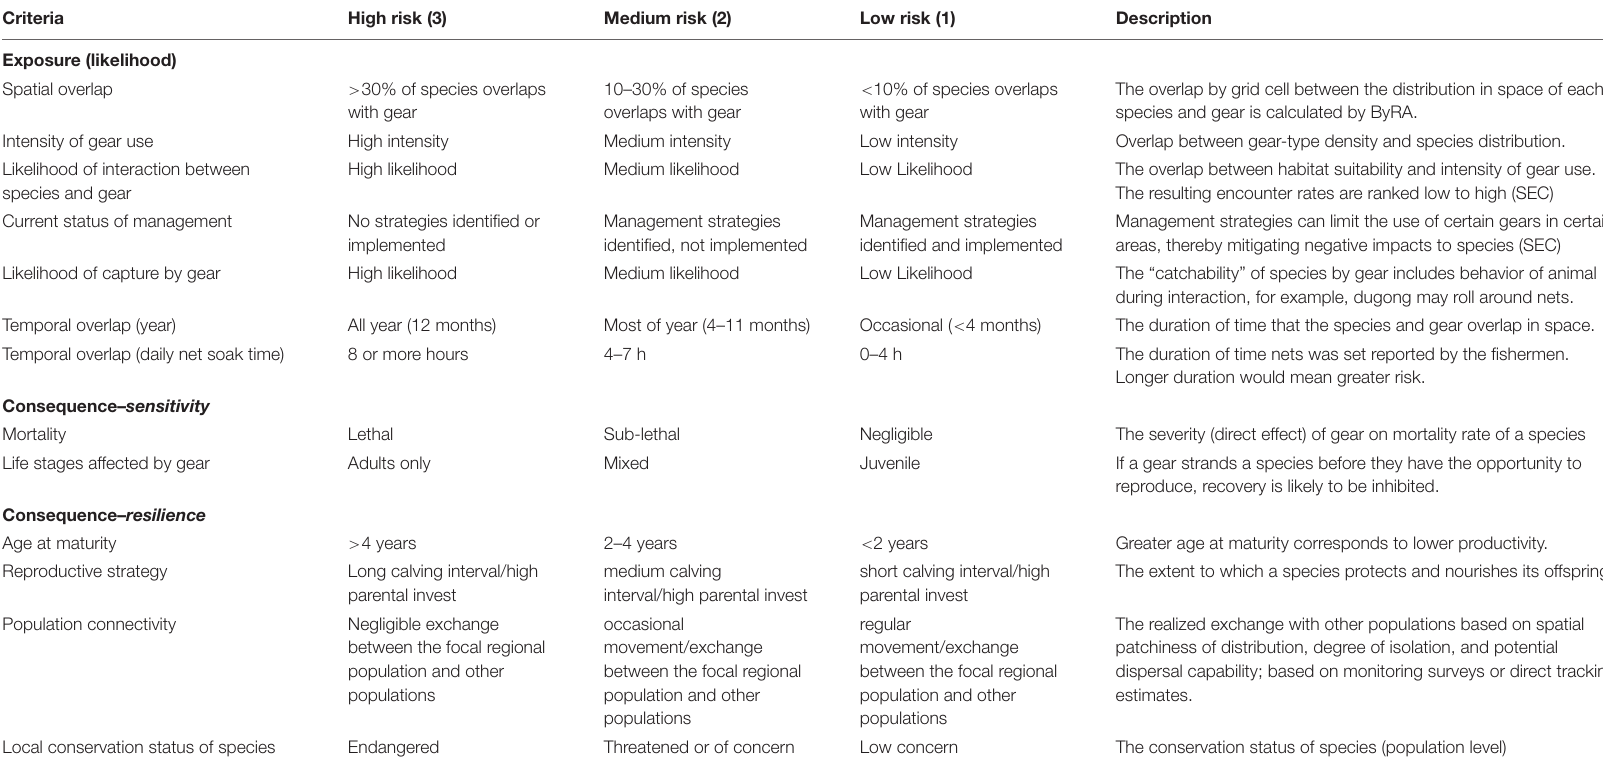
TABLE 1 | Exposure and Consequence scoring criteria and definitions used to guide final ratings derived from Verutes et al. (2020).